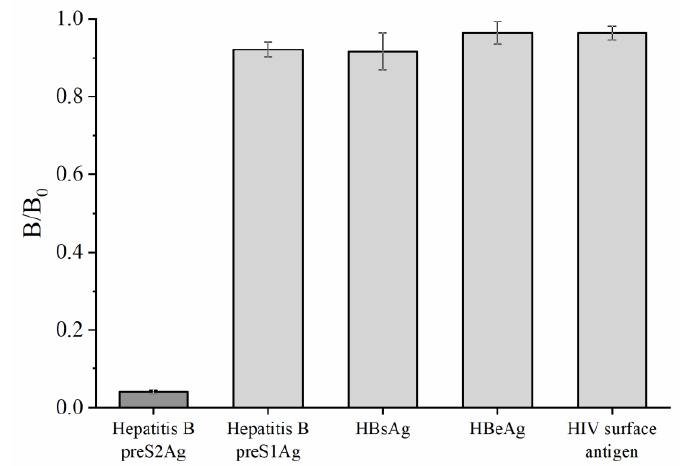
Figure 7. Quantitative results of the specificity analysis. The error bars represent the standard deviation of three repeats (n = 3).